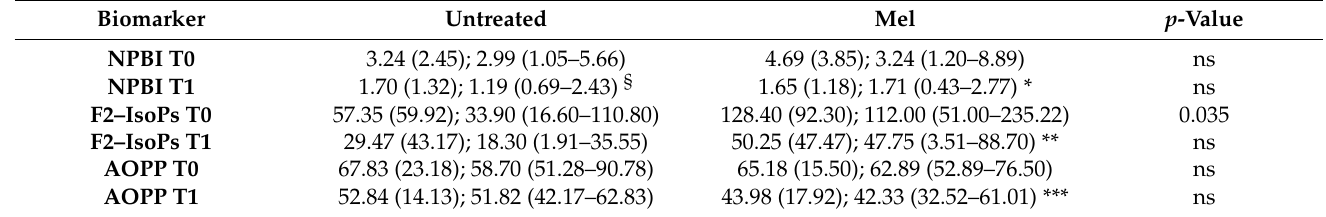
Table 2. Plasma levels of NPBI, F2-IsoPs, and AOPP in untreated newborn infants and newborns treated with melatonin (Mel) in the preoperative (T0) and postoperative (T1)